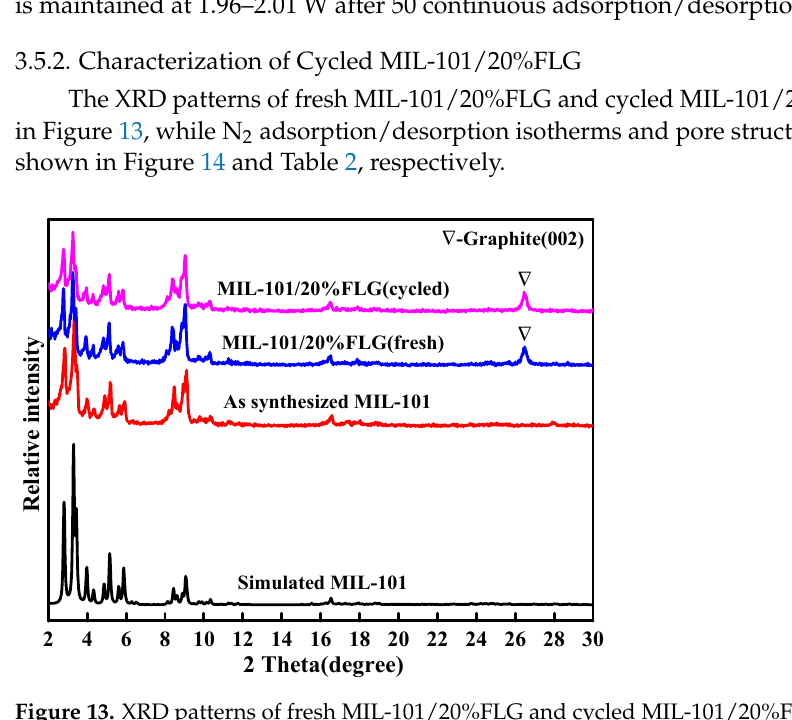
Figure 13. XRD patterns of fresh MIL-101/20%FLG and cycled MIL-101/20%FLG. As shown in Figure 13, the major peaks of MIL-101 components are retained in MIL- 101/20%FLG, which indicates well the coexistence between FLG and MIL-101. After con- tinuous adsorption cooling cycles, the crystallinity of cycled MIL-101/20%FLG is rarely changed and the phase structure of MIL-101/20%FLG remains stable.